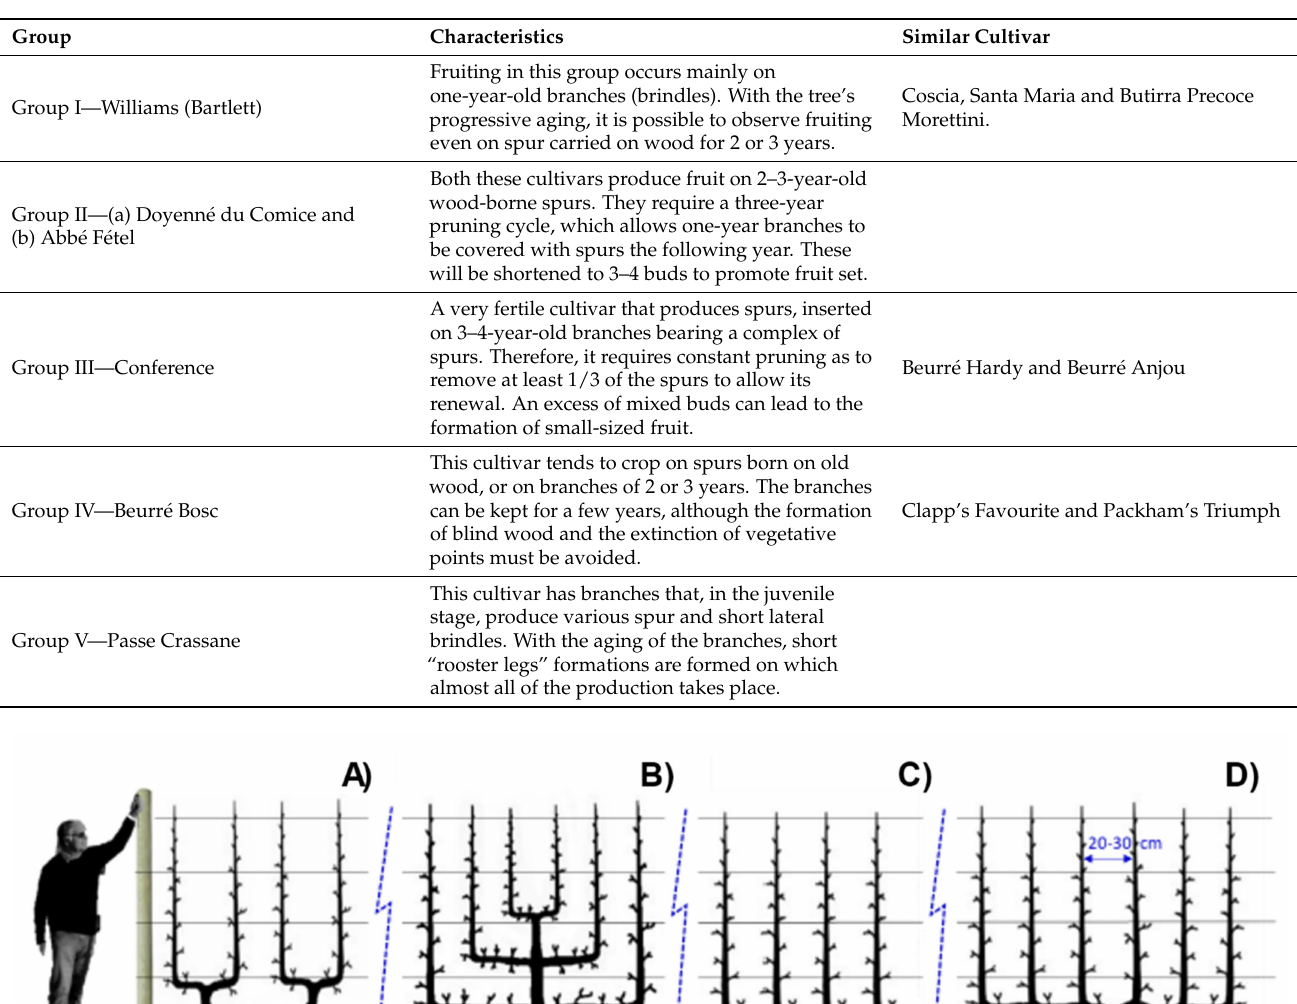
Table 4. Group of pear cultivar classified by habit (Modified from [19,53]).